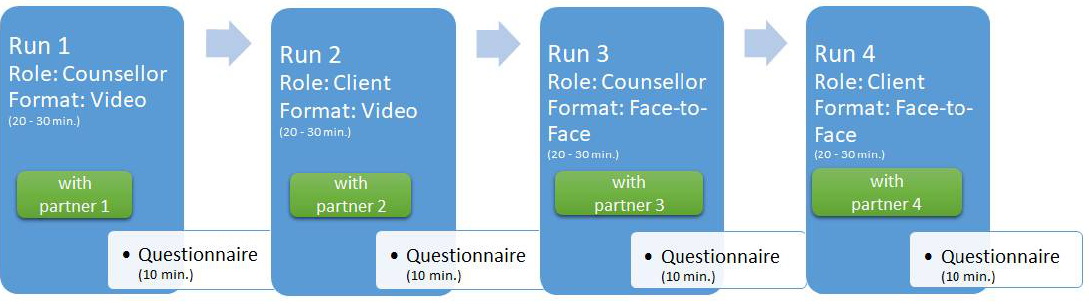
Figure 1. Experimental procedure.